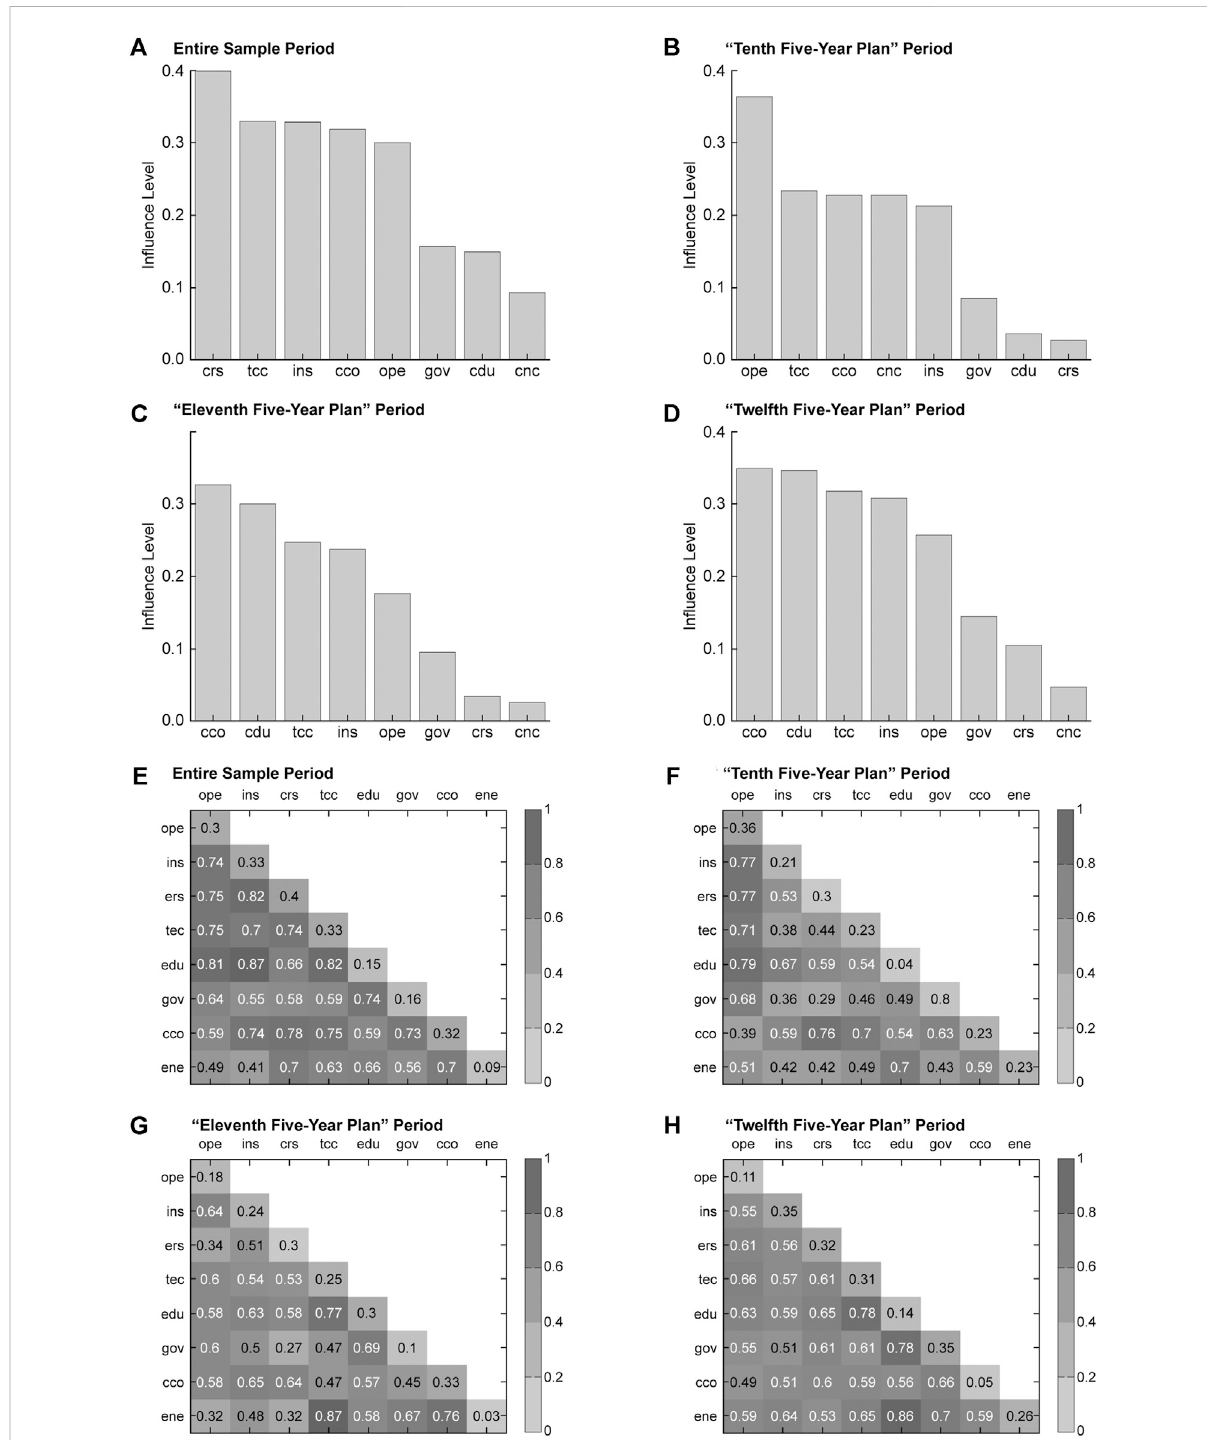
FIGURE 3 DriversofspatialGTFPheterogeneityinChina.Notes: (A) Resultsofthedetectionoffactorsin fl uencingGTFPinChinafortheentiresampleperiod; (B) Resultsofthedetectionoffactorsin fl uencingGTFPinChinaduringthe “ TenthFive-YearPlan ” period; (C) Resultsofthedetectionoffactorsin fl uencingGTFP in China during the “ Eleventh Five-Year Plan ” period; (D) Results of the detection of factors in fl uencing GTFP in China during the “ Twelfth Five-Year Plan ” period; (E) Interaction detection results of factors in fl uencing GTFP in China for the entire sample period; (F) Interaction detection results of factors in fl uencingGTFPinChinaduringthe “ TenthFive-YearPlan ” period; (G) Interactiondetectionresultsoffactorsin fl uencingGTFPinChinaduringthe “ Eleventh Five-Year Plan ” period; (H) Interaction detection results of factors in fl uencing GTFP in China during the “ Twelfth Five-Year Plan ”